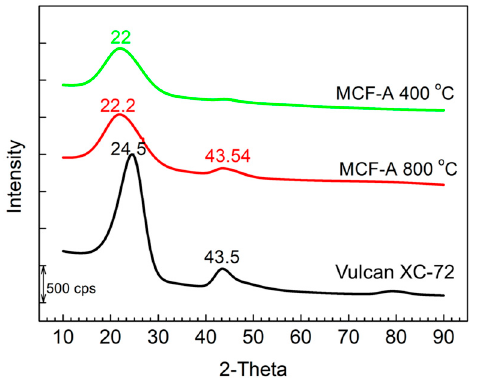
Figure 2. XRD patterns of MCF-A under each calcination step and Vulcan XC-72 for comparison.